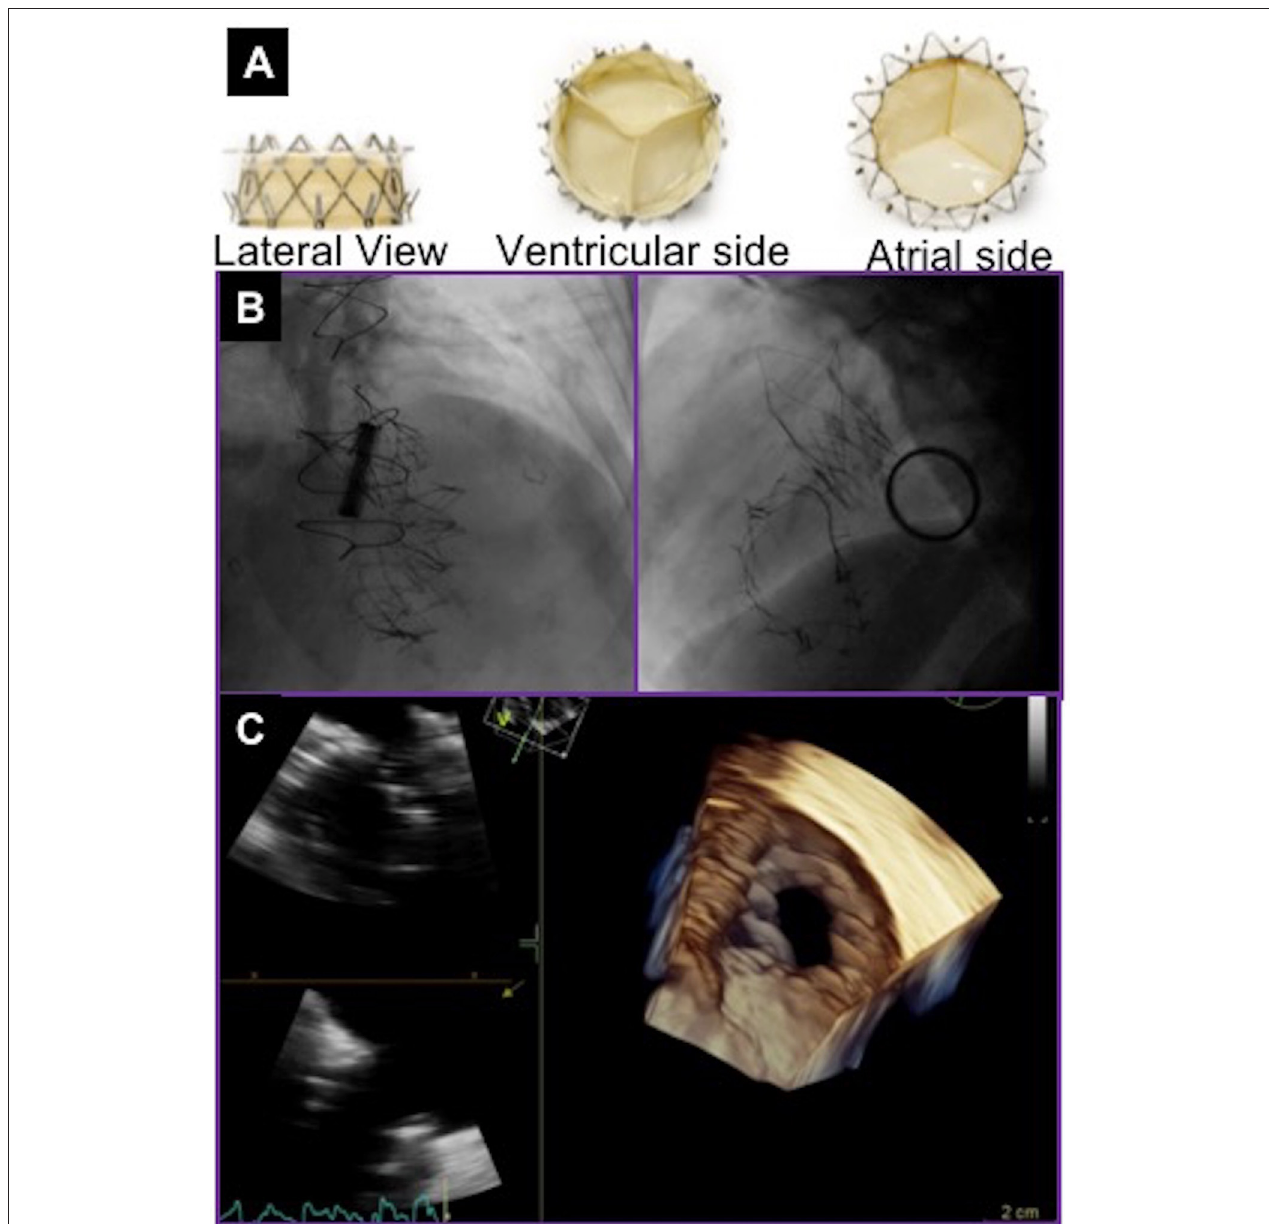
FIGURE 4 | NaviGate valve and final result after valve deployment. (A) NaviGate Valve Profile. (B) Fluoroscopic images of NaviGate deployed in tricuspid annulus with relative relations with mitral valve (previous mitral valve replacement) and aortic valve (previous transcatheter aortic valve implantation). (C) Echocardiographic images showing good expansion and stable position of the NaviGate